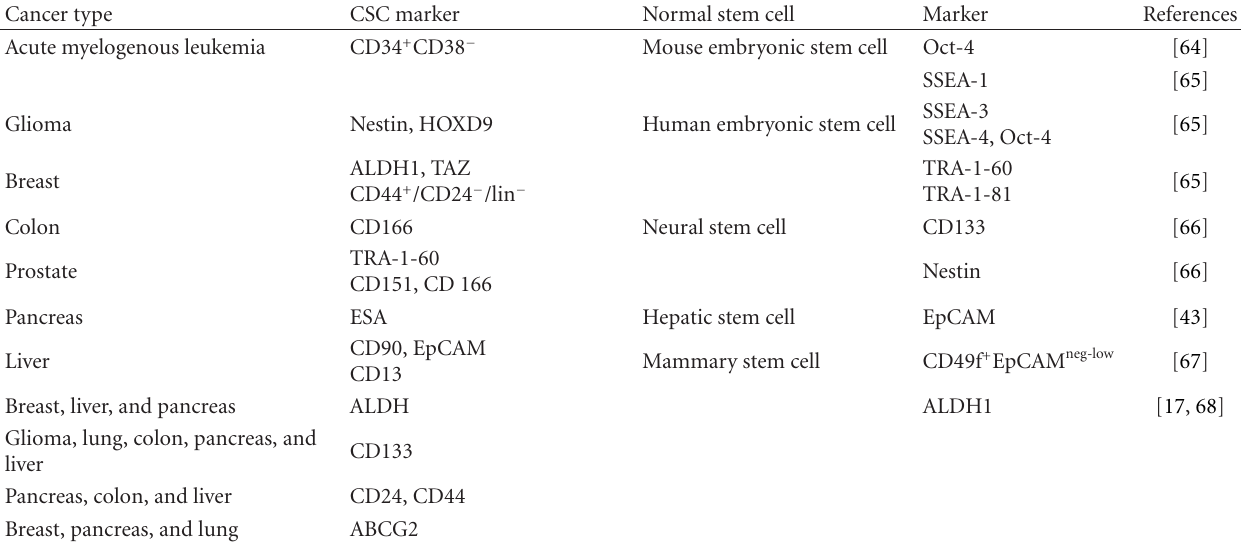
Table 1: Comparison of the biomarkers of CSC and normal stem